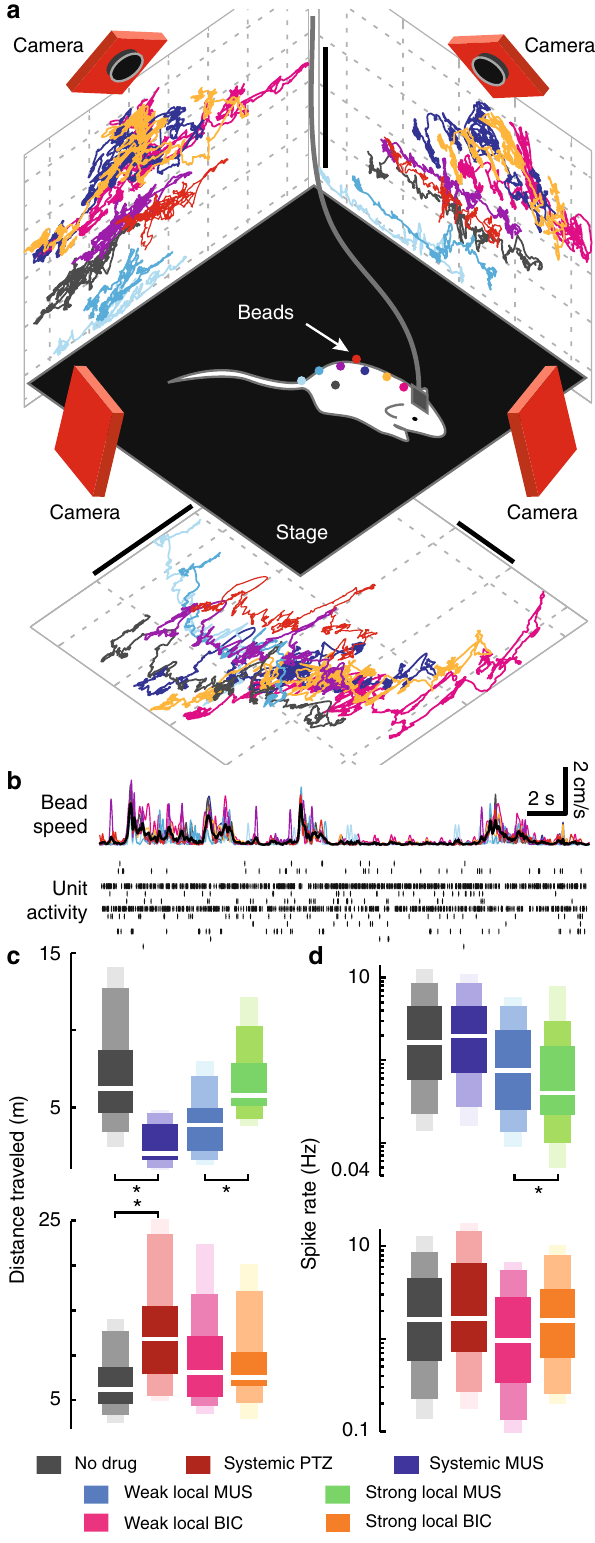
population average), but for some neurons population coupling was negative (anticorrelated). Across units, population coupling varied over three orders of magnitude. However, it was rather stable on the timescale of one recording. Population coupling for the fi rst half of each recording was strongly correlated with that